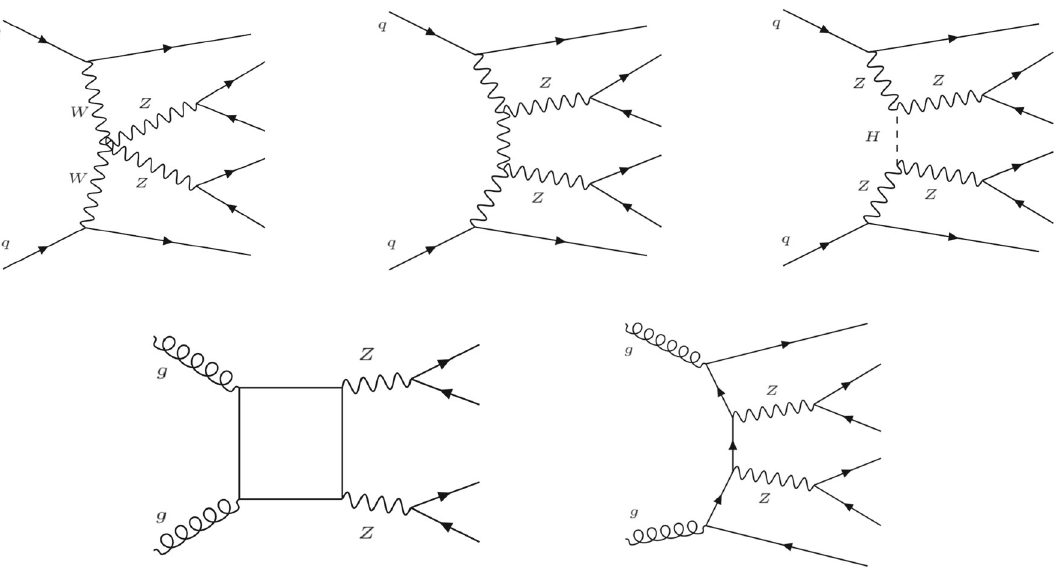
Fig. 3 Representative Feynman diagrams for vector boson scattering in the Z Zjj final state (top row) and its main background, the QCD-induced diboson production (bottom